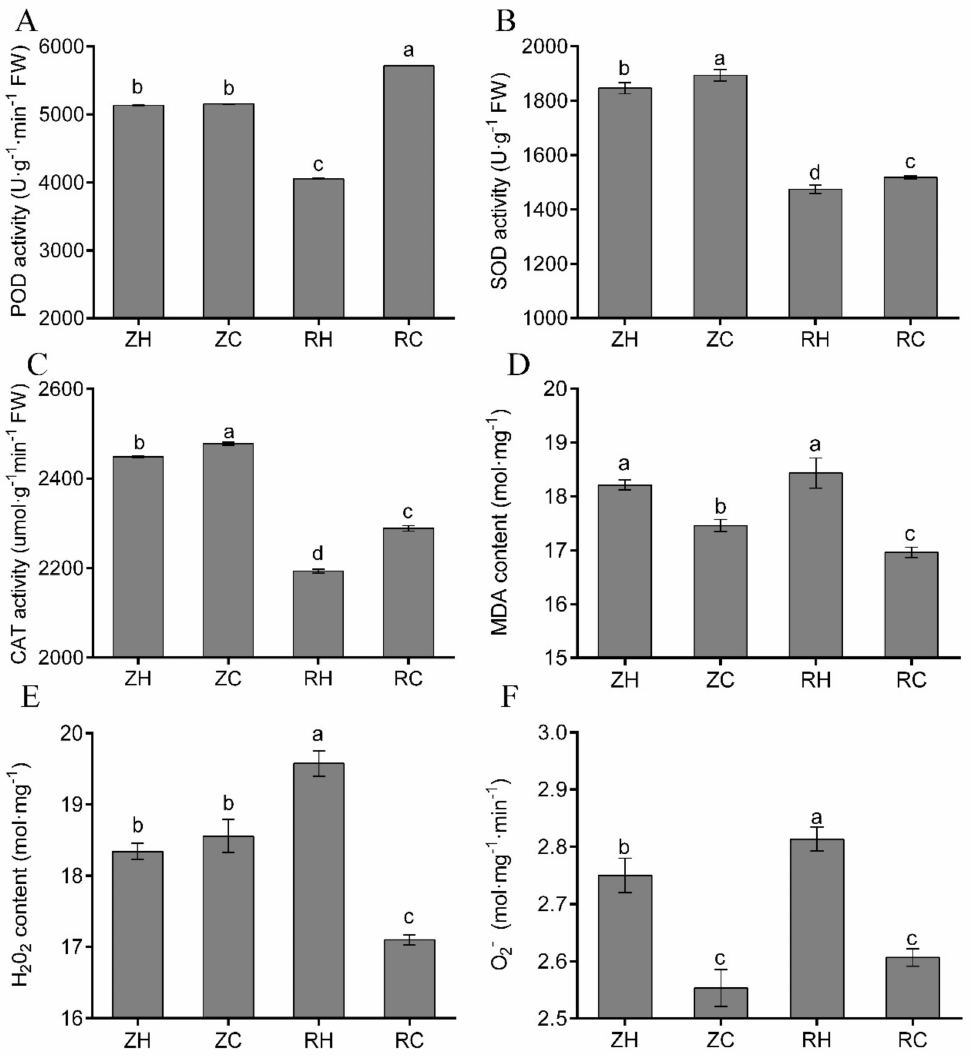
Figure 10. E ff ects of exogenous Ca 2 + on the antioxidant system in potatoes. We measured the levels of ( A ) POD activity, ( B ) SOD activity, ( C ) CAT activity, ( D ) MDA content, ( E ) H 2 O 2 content and ( F ) O 2 − in di ff erent treatments. Values represent the mean ± S.E. ( n = 3). Letters indicate significant di ff erences at p < 0.05 according to Duncan’s multiple range